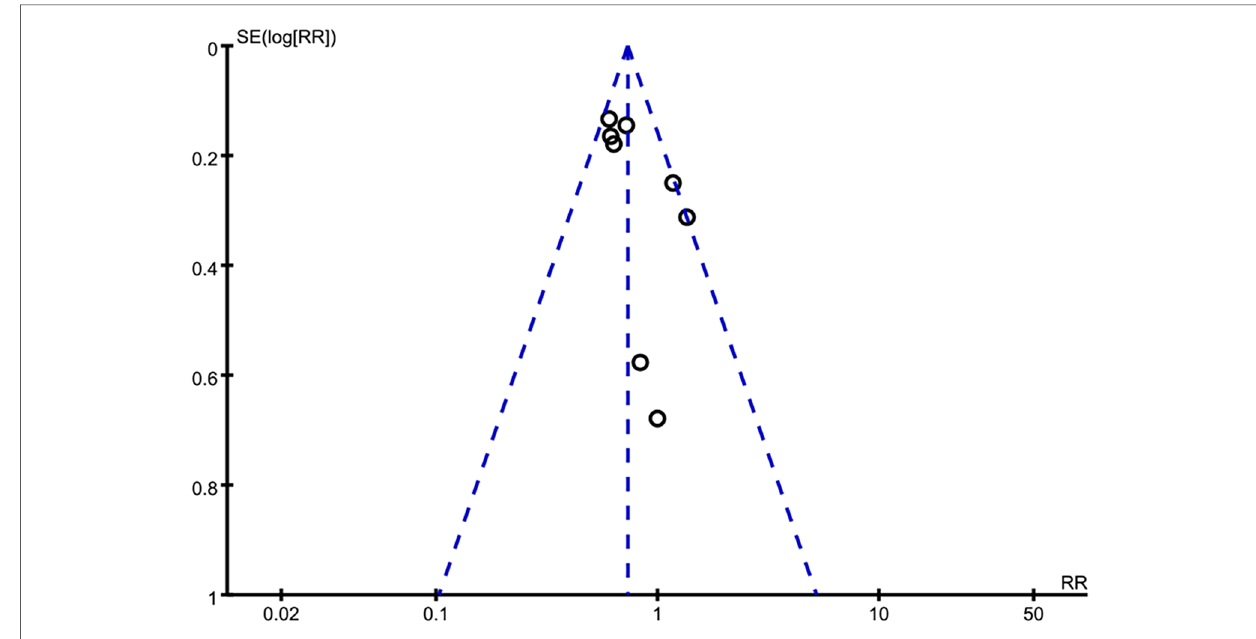
FIGURE 7 Funnel plot of long-term all-cause mortality. The asymmetrical funnel plot indicates publication bias of this